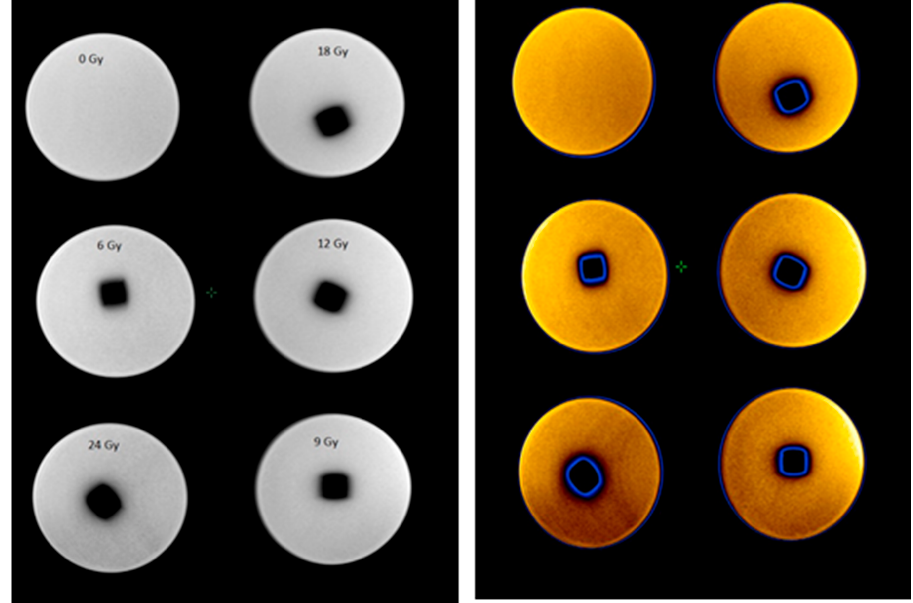
Figure 7. NMR images of polymer gel samples irradiated to different doses.